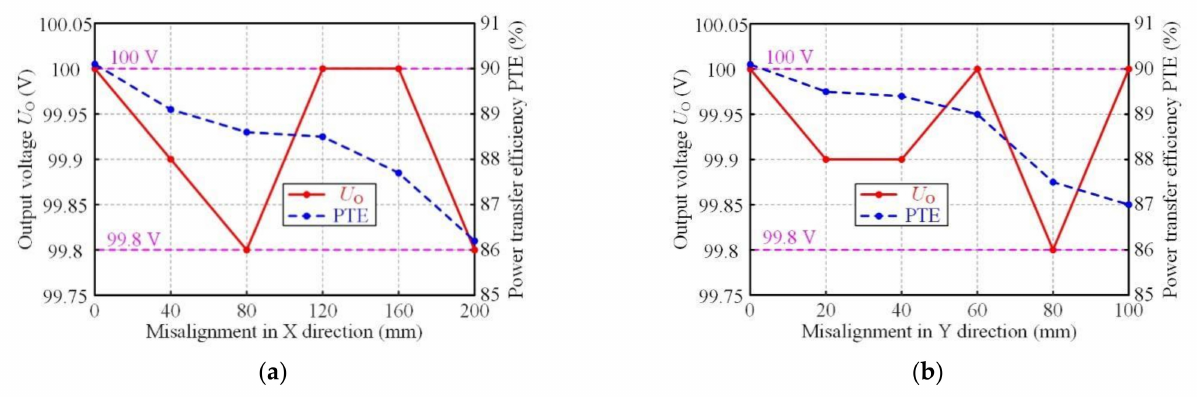
Figure 14. Plots of the output voltages and PTEs versus ( a ) X- and ( b ) Y-direction misalignment. In the whole operating area, the output voltage is stable which only fluctuates by 0.2%. The accuracy of the closed-loop control is demonstrated. PTE decreases when X- and Y-direction misalignments are increased. However, the minimum PTE is as high as 86.2% even if the X-direction misalignment is 200 mm. More importantly, such an efficiency